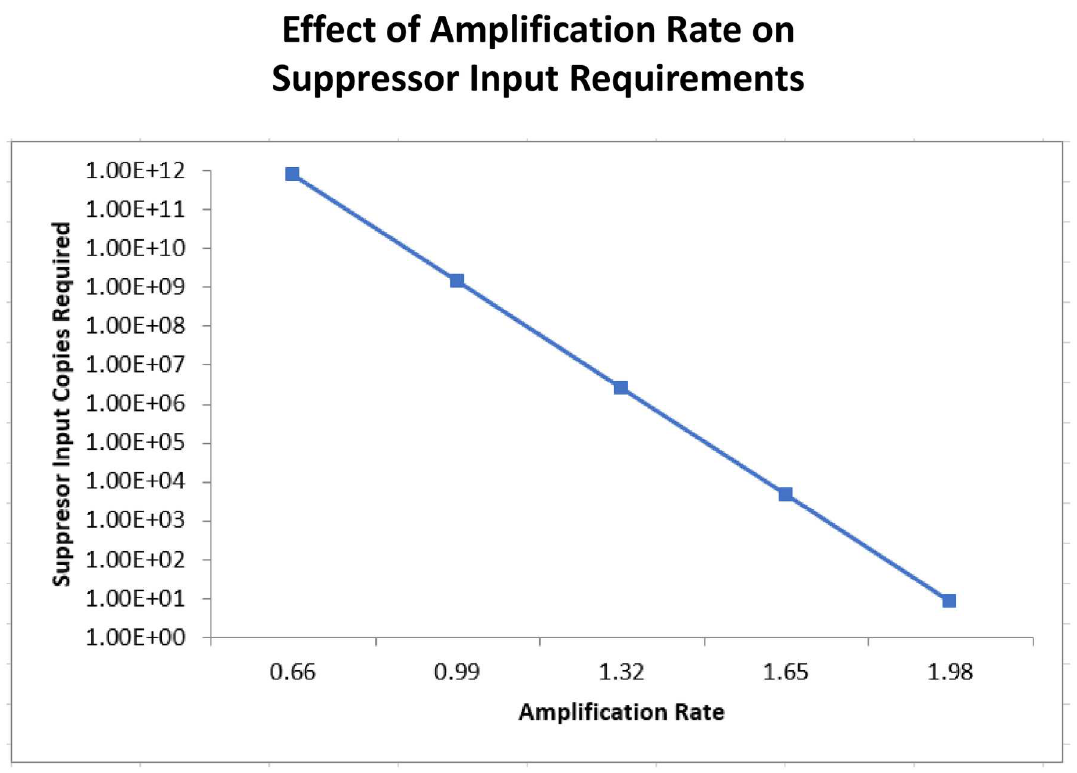
Fig 2. A mathematic model of the effect of amplification rate on suppressor input requirements. An equation is used to determine how many copies of suppressorinput wouldbe requiredfor a specifiedthreshold amount (Ta) with various suppressoramplification doublingrates at a fixed amplification rate for the target organism